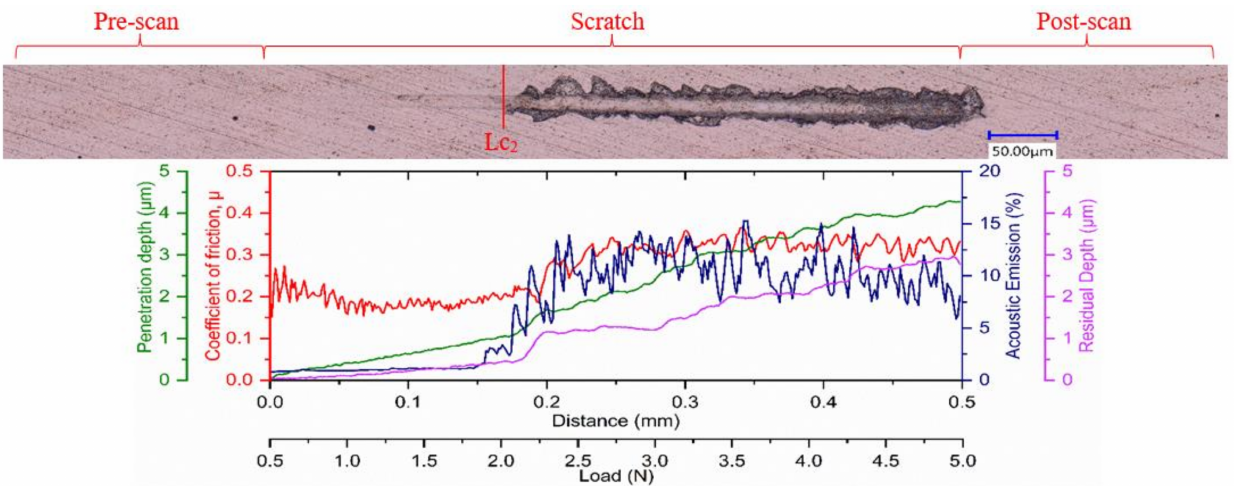
Figure 10. Ramped load scratch test data with optical images of the scratch track for Coating A.